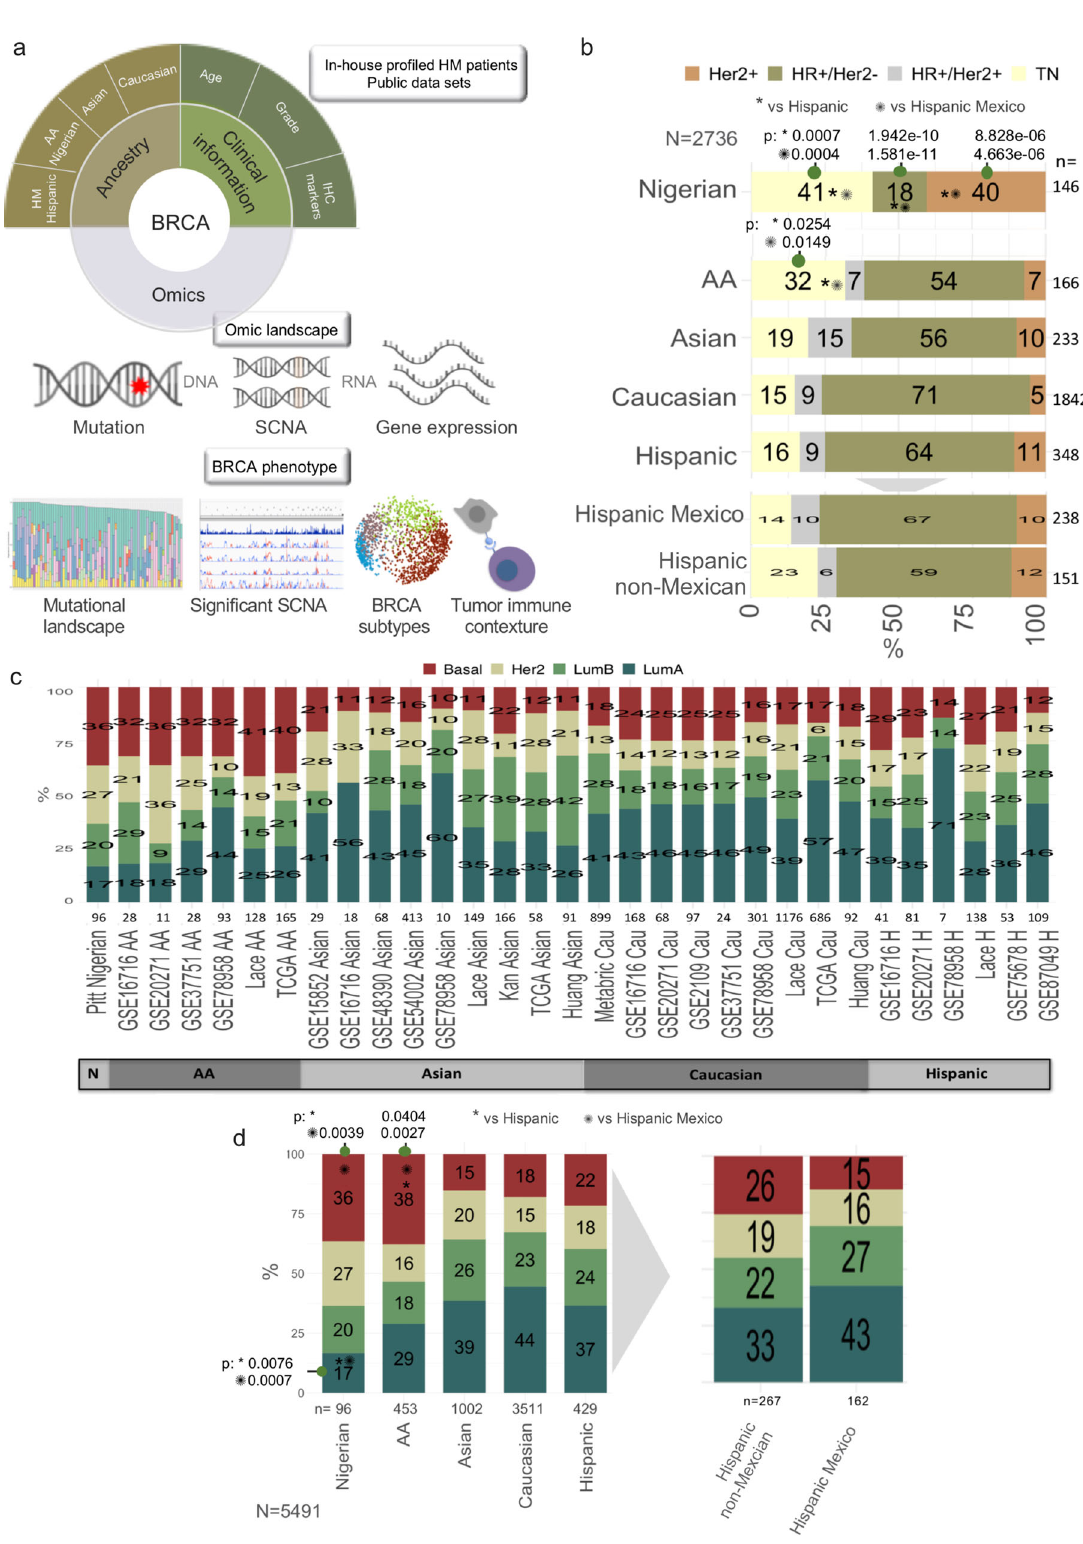
43% LumA tumors, 27% LumB, 16% HER2-enriched and 15% Basal-like (Fig. 1d). Compared to other biospecimen collections including Hispanic patients ( N = 313) from M.D.